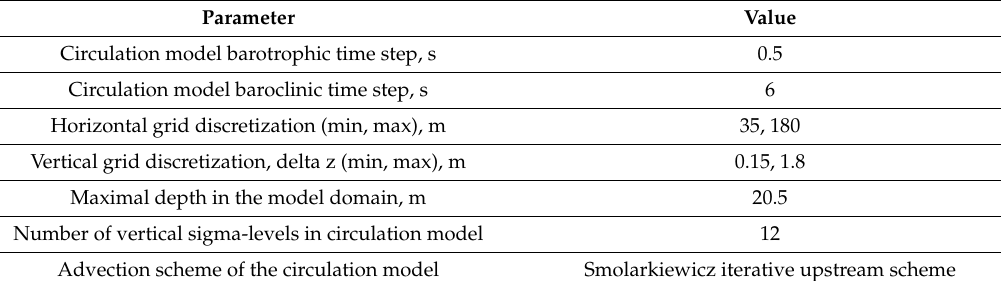
Table 1. Main parameters of coupled Hanhikivi